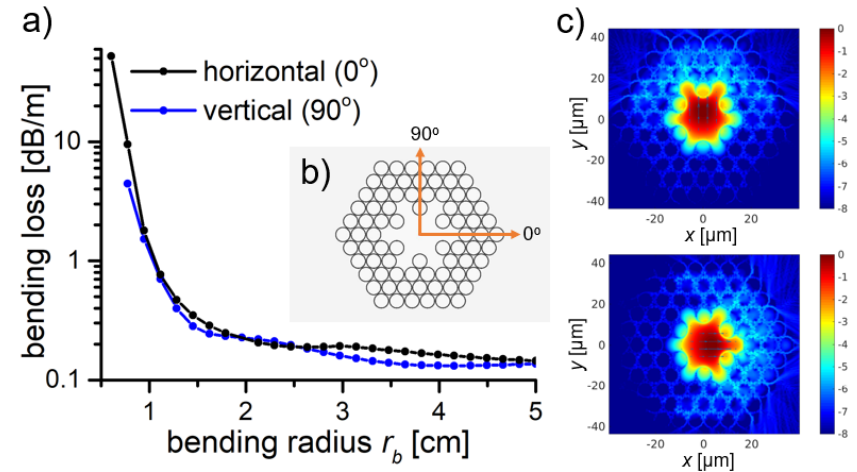
Figure 10. ( a ) Calculated bending losses of the fundamental modes for star structures for different bend orientation; ( b ) Bend-orientation scheme. The orange arrows indicate the direction of the—0° is horizontal, while 90° is vertical bend. ( c ) Modal field distribution, calculated for the fundamental mode at bending radius r b = 1.3 cm, for vertical (up) and horizontal (down) bend orientation. The color scale bar on the left defines the electromagnetic field intensity. The main reason of the higher bending losses is the coupling between the core and cladding modes, occurring in the direction of the bend.